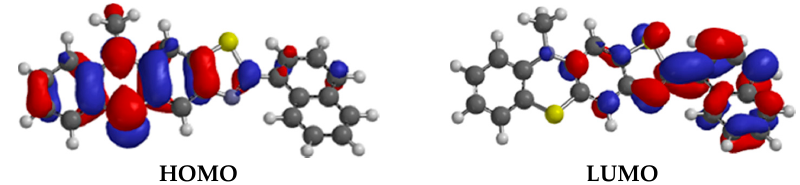
Figure 4. Frontier molecular orbital density plots for TAPTZ 3e resulted from DFT calculations performed at B3LYP/6-31G* level of theory (the iso-contour value was set to 0.02). The orbital wave functions are positive in regions coloured in red and negative in regions coloured in blue. The ball and stick molecular models display carbon atoms in grey, hydrogen atoms in white, sulfur atoms in yellow and nitorogen atoms in blue.